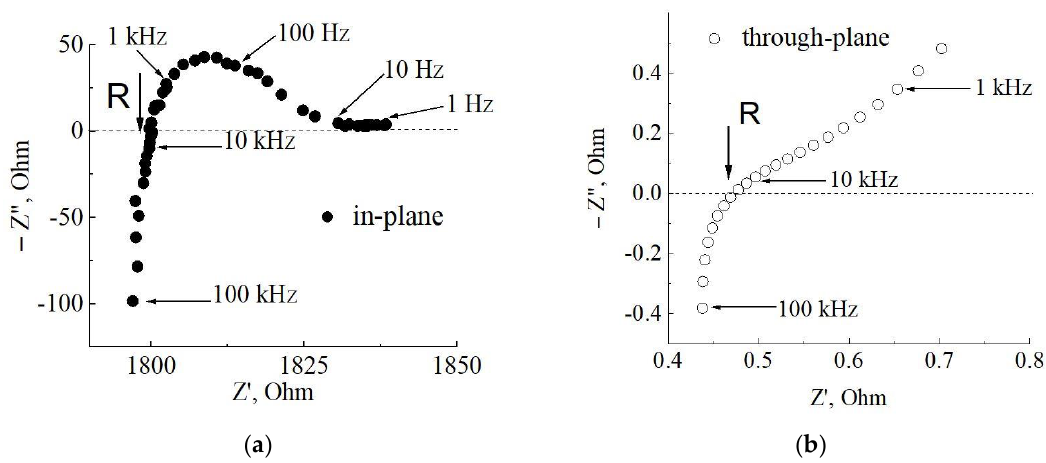
Figure 5. Impedance spectra of the co-PNIS 70/30 membrane measured: ( a ) in-plane ( l = 10 mm, h = 8 mm, d = 72 μm) direction; and ( b ) through-plane (S = 0.25 cm 2 , d = 58 μm) direction. Arrows indicate the bulk resistance of the film R. The numbers at the impedance points correspond to the measurement frequencies.